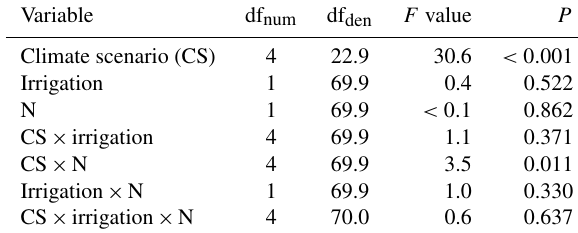
Table B2. Summary of analyses for the effects of climate scenario (CS), irrigation and N deposition on root carbon stock of subalpine grassland in 2017, after 5 years of experimental treatment. F tests refer to the fixed effects of a linear mixed-effects model; the marginal and conditional R 2 values were 0.47 and 0.63, respectively. No data were available for CS1 and the intermediate N-deposition treatment N3. Variable df num df den